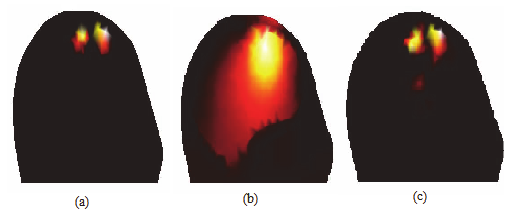
Fig. 9: Longitudinal section of the reconstructed images with the perturbations located in the movement region of the brain a) The original distributions of the two perturbations (b) The images reconstructed by the sLORETA alone (c) The images reconstructed by shrinking sLORETA-FOCUSS based on [37].